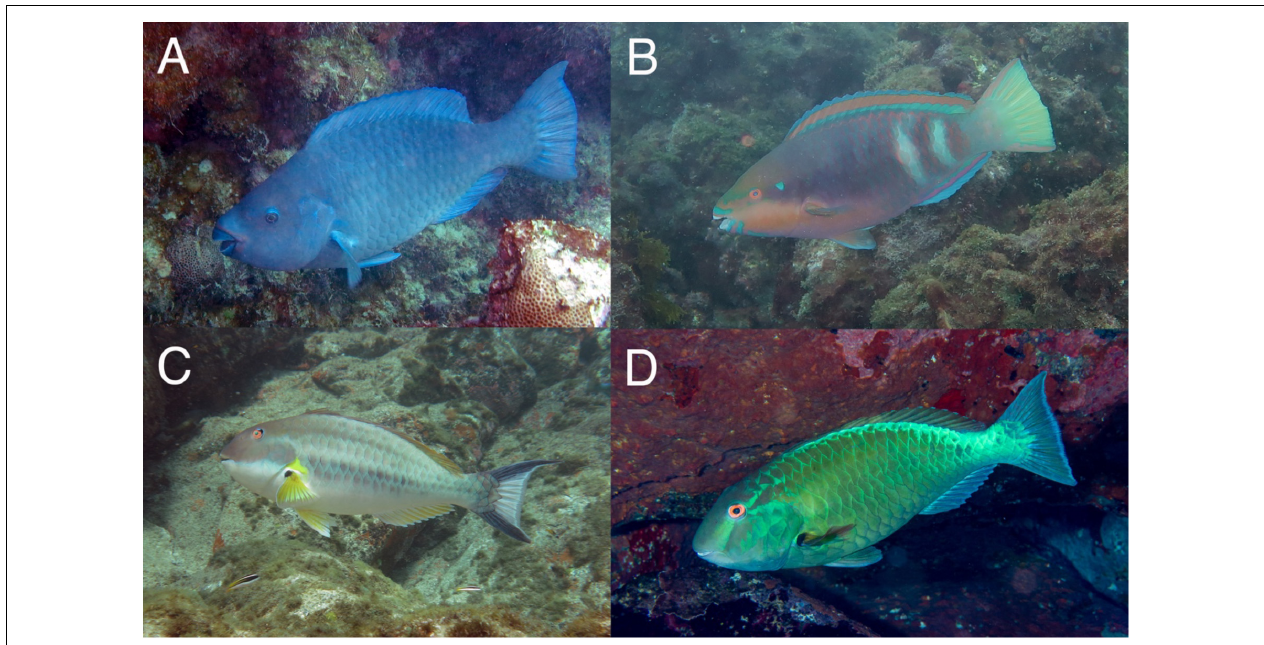
FIGURE 2 | Brazilian endemic parrotfishes now under inverted management: (A) Scarus trispinosus ; (B) Scarus zelindae ; (C) Sparisoma axillare ; (D) Sparisoma frondosum . Photos: C.L.S Sampaio (A–C) and L.A. Rocha (D)